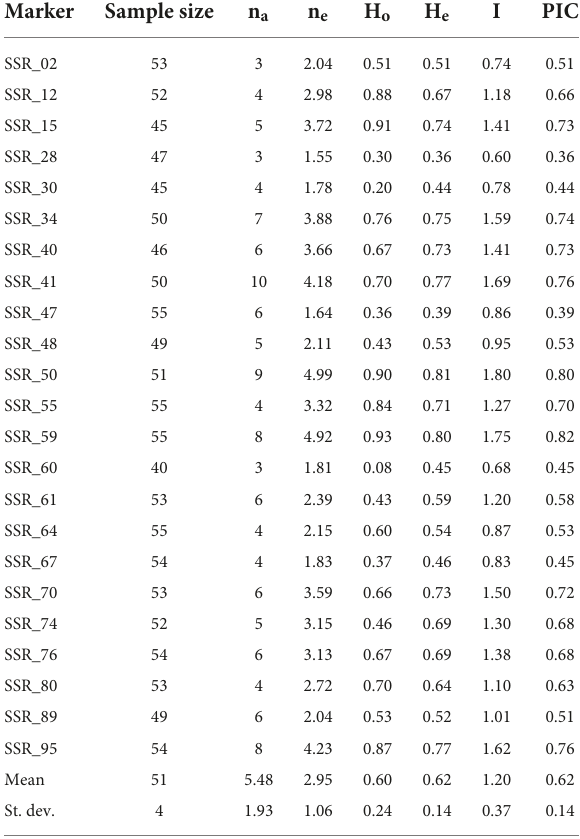
TABLE 3 Simple sequence repeat descriptive statistics reporting marker locus name, sample size of individuals successfully amplified for each locus, number of observed alleles (n a ), number of effective alleles (n e ), observed heterozygosity (H o ), expected heterozygosity (H e ), Shannon’s information index (I), and polymorphic information content